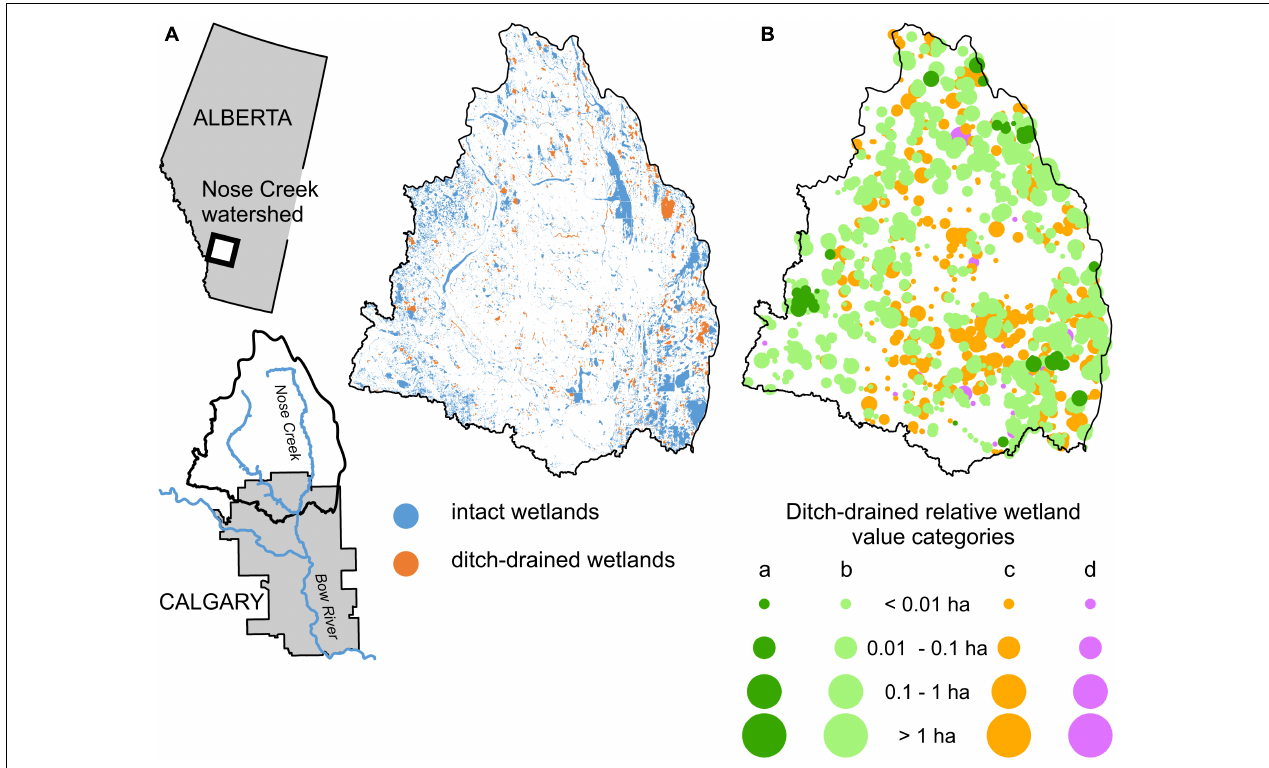
FIGURE 3 | (A) Intact and ditch-drained wetlands in the Nose Creek watershed. A total of 20,027 intact wetlands with a total area of 12,500 ha cover 14.1% of the watershed with a median size = 801 m 2 and an average size = 6,241 m 2 . A total of 1,587 ditch-drained wetlands with a total area of 1,220 ha cover 1.4% of the watershed with a median size = 790 m 2 and an average size = 7,690 m 2 . (B) Locations and sizes of in ditch-drained wetlands in the Nose Creek watershed per relative wetland value